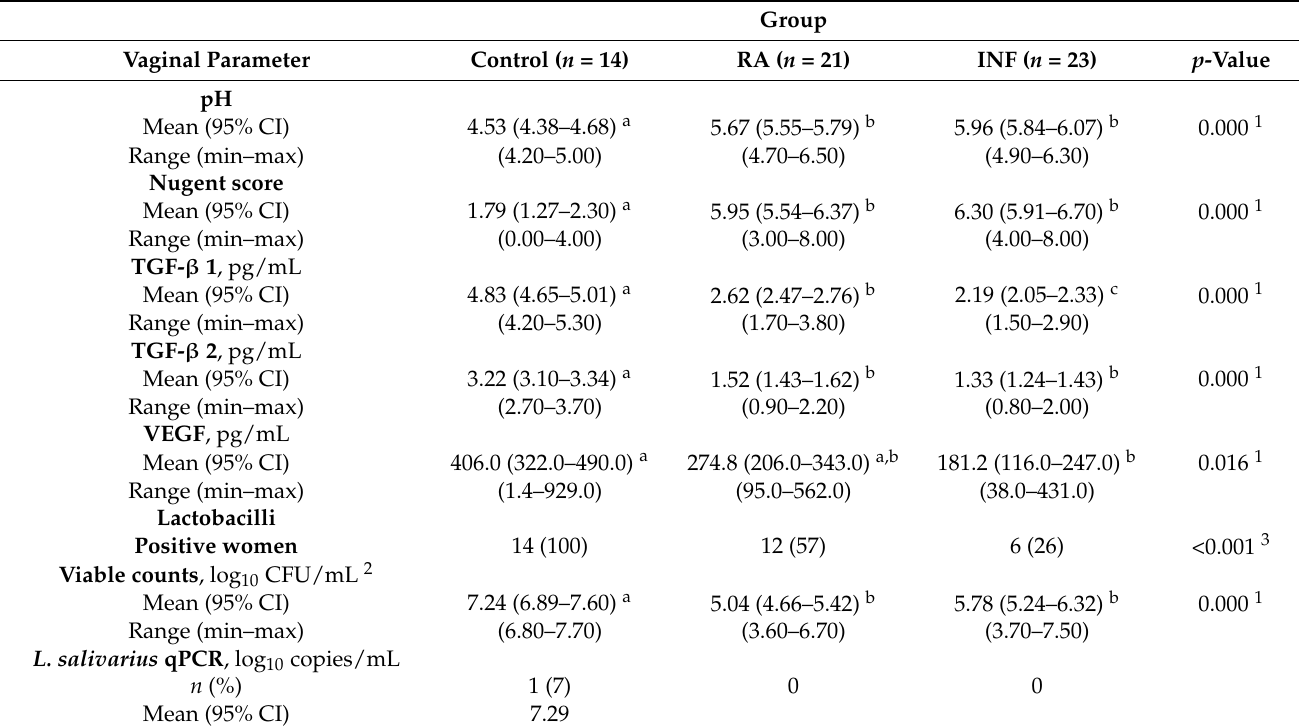
Table 2. Comparison of baseline vaginal parameters (pH, Nugent score, cytokines, and microbiology) of the participants ( n = 58) which included fertile women (Control group), women with a history of repetitive abortion (RA group), and women with infertility of unknown origin (INF group).